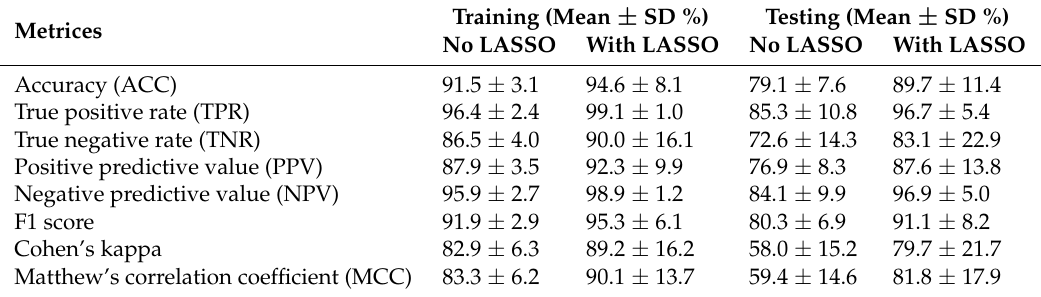
Table 7. Phase 2: Supervised machine learning result—SVM with 3rd order Polynomial kernel.